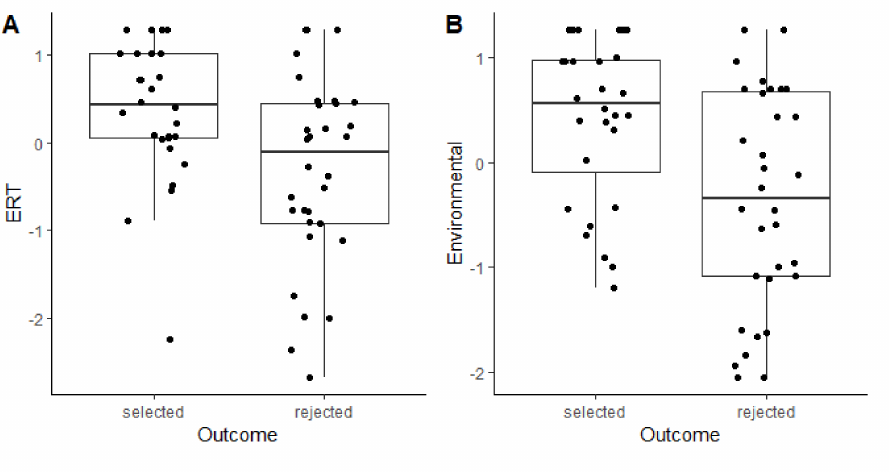
Figure 2. Distribution of component scores from the Emotional Reactivity Test ( A ) and Environmental Test ( B ) for 3-months -old puppies as a function of eventual program outcome. Horizontal lines represent medians, boxes represent the interquartile range, and whiskers represent the range of values within 1.5 × interquartile range. Dots are individual data points, jittered to reduce